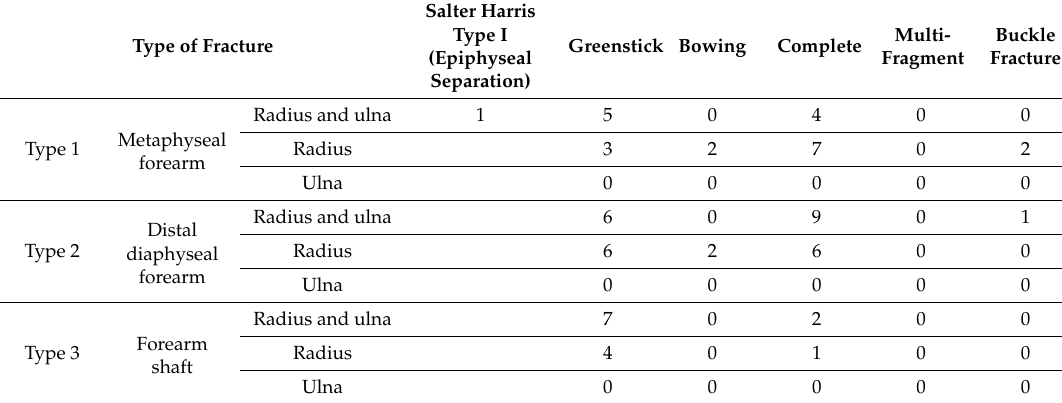
Table 1. Fracture types in the study population ( n =